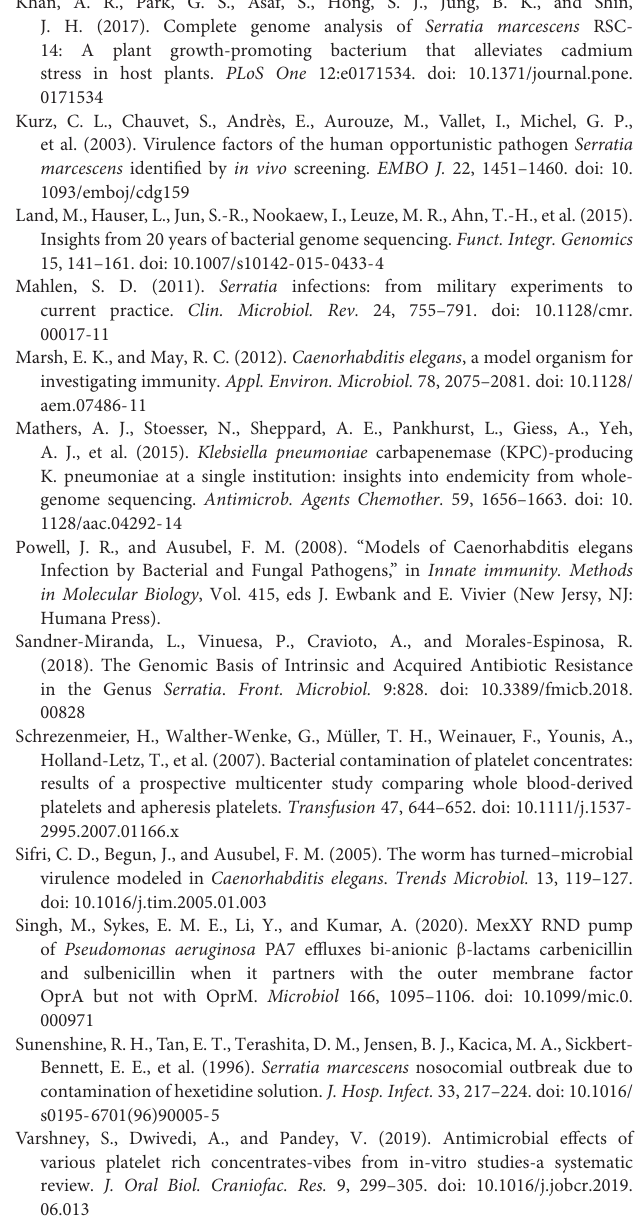
Supplementary Figure 1 | Genomic Islands of (A) CBS11, (B) CBS12, and (C) pAM01. The islands are marked according to the method of detection; SIGI-HMM (Orange), DIMOB (Blue), IslandPick (Green), and Integrated (Red). Supplementary Figure 2 | CARD Resistance Gene Identifier program hits in (A) CBS11, (B) CBS12, and (C) pAM01. The different levels of hits: Perfect (Green), Strict (Yellow), and Loose (Orange), are color